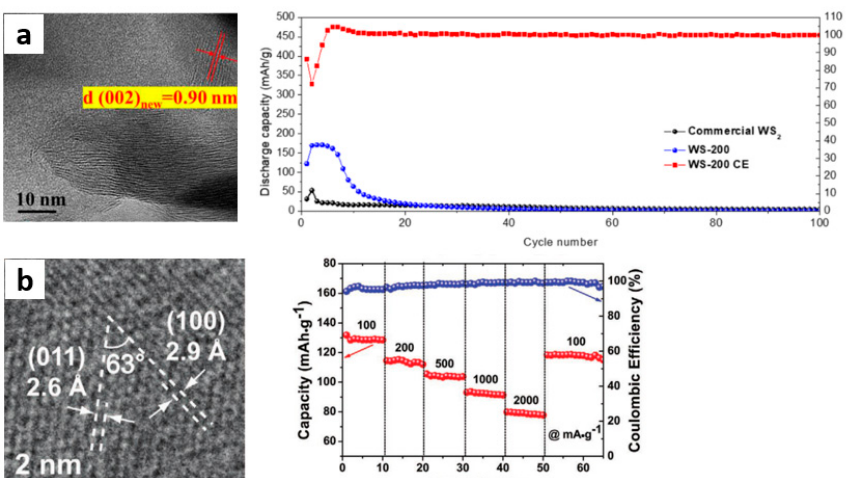
( b ) HRTEM image and rate performance of VSe 2